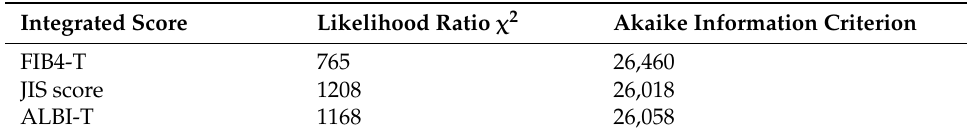
Table 4. Evaluation of scores (n = 3800).